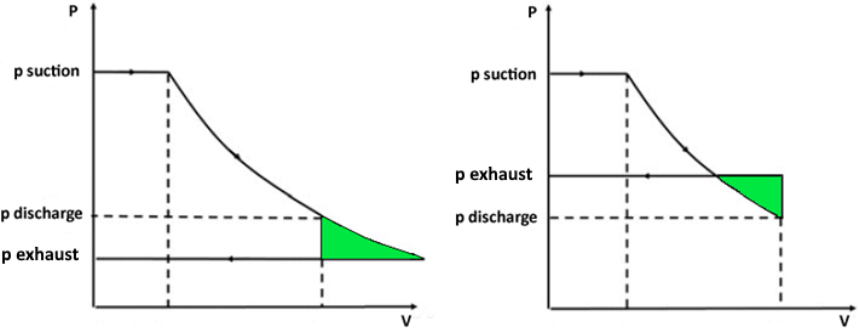
Figure 2. Under-expansion ( left ) and over-expansion ( right ).